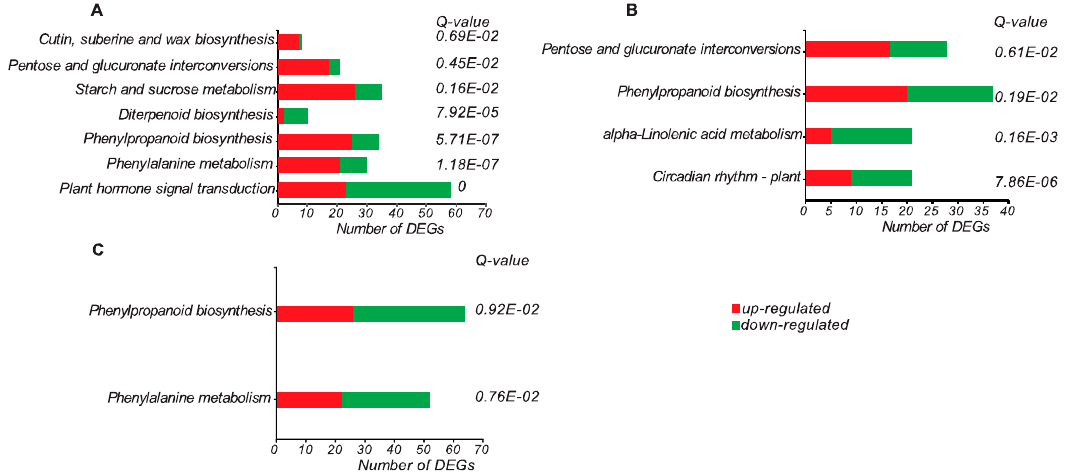
Figure 3. Significant enriched KEGG pathways during the graft process. ( A ) Comparison of 8 days/0 days; ( B ) comparison of 15 days/0 days; ( C ) comparison of 30 days/0 days.